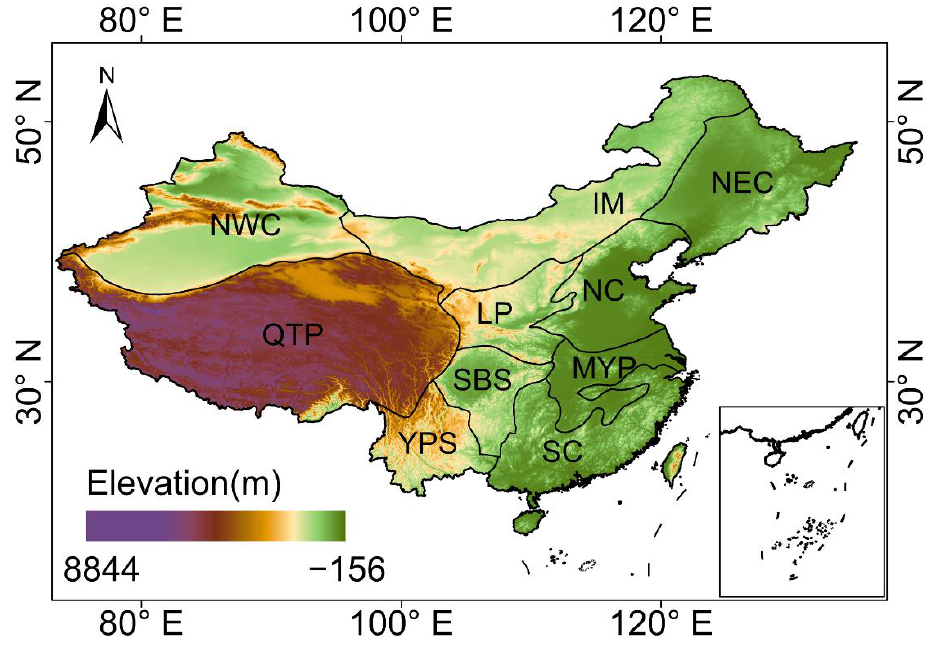
Figure 1. Topographical features and geographical region of China.